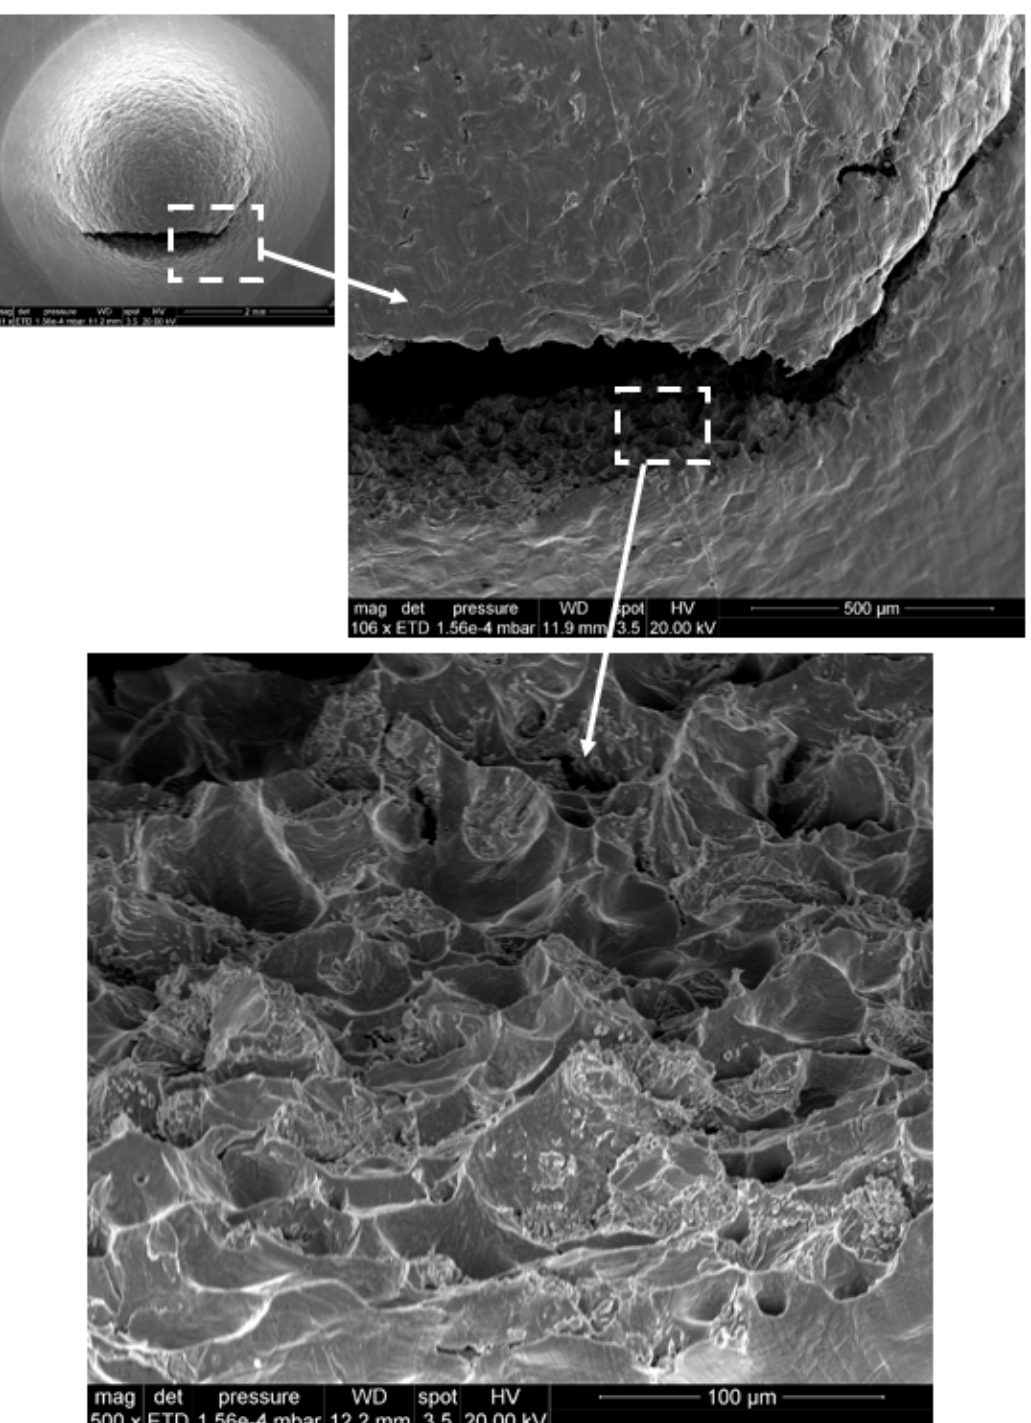
Figure 7. Aspect of premature fracture (ductile–intergranular) in the SPT specimen E3.